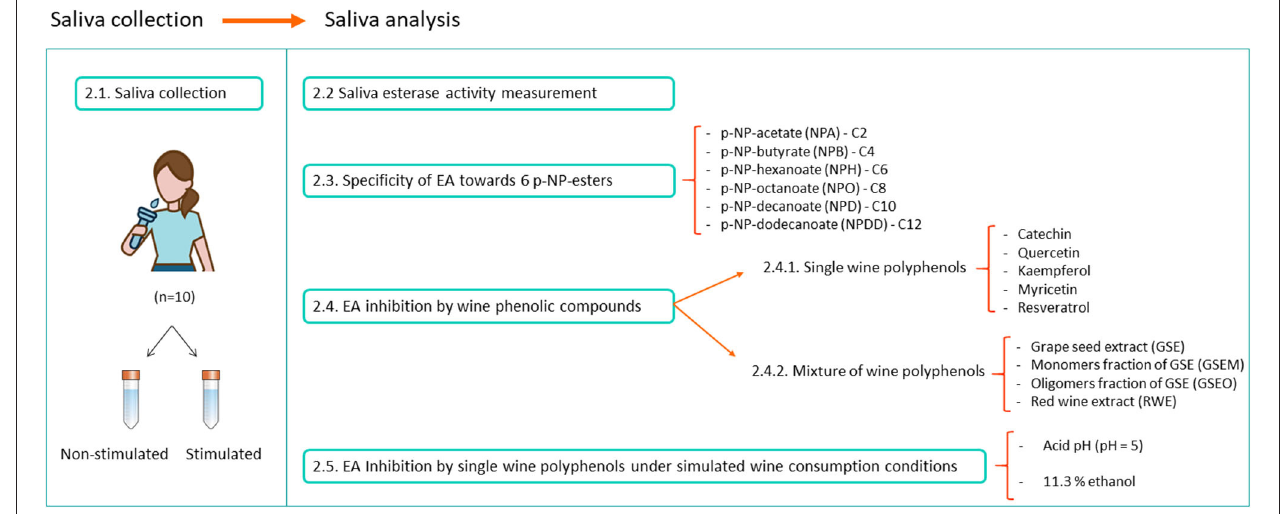
FIGURE 1 | The experimental procedure followed for the saliva collection and saliva esterase activity (EA)